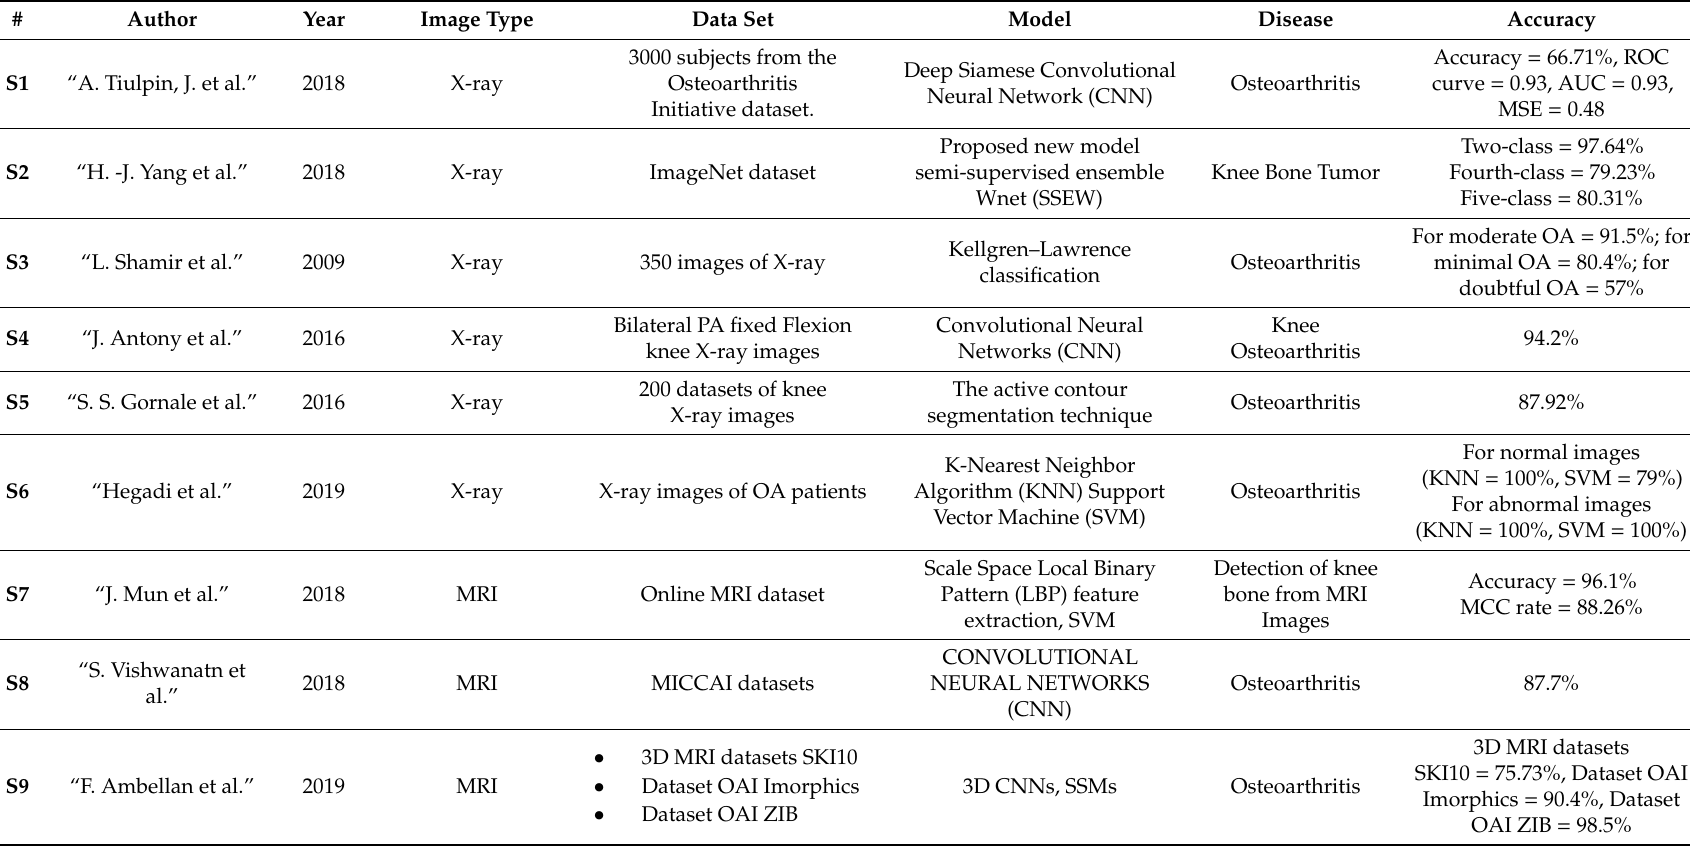
Table 9. Extracted data for knee bone-related MRI, CT scans, and X-rays using deep learning